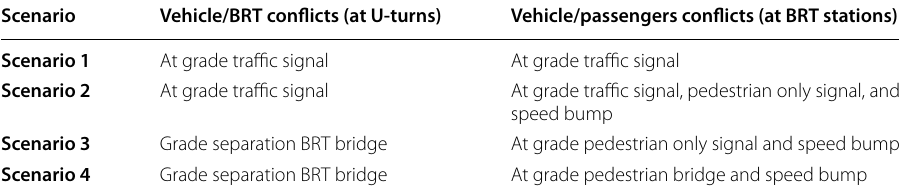
Table 1 Conflict resolution methods